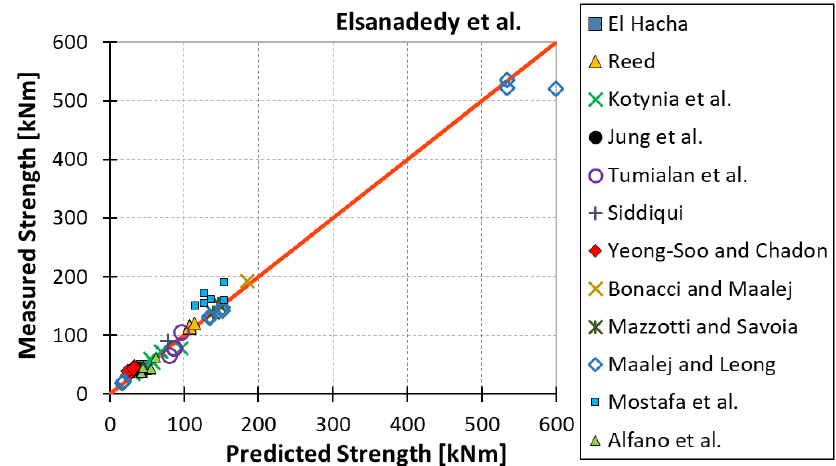
Figure 8. Measured flexural strength versus Said and Wu model prediction.